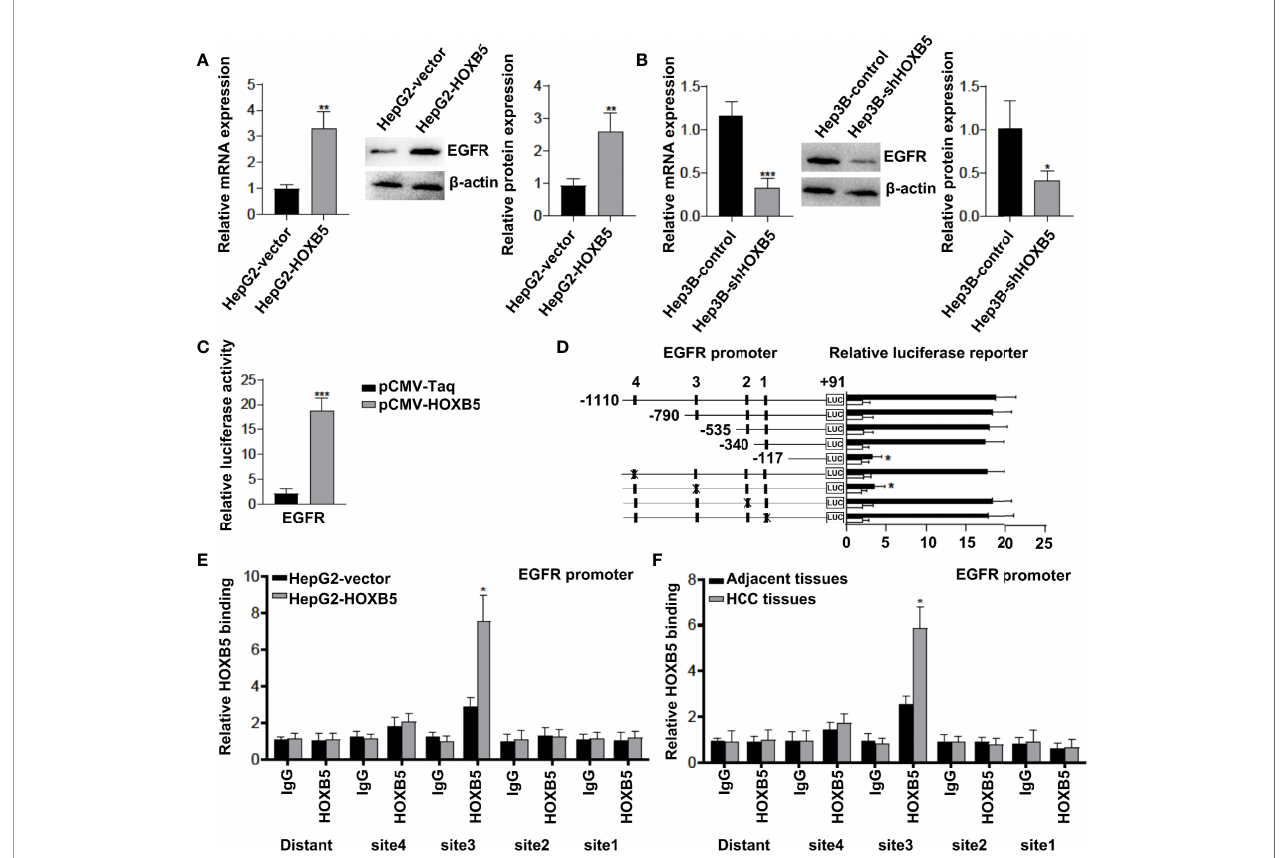
FIGURE 3 | EGFR is a direct transcriptional target of HOXB5. (A, B) Expression of EGFR in HepG2-HOXB5 and Hep3B- sh HOXB5, and their corresponding control cell lines as tested by qRT-PCR and Western blot. Data are mean ± SD. * p < 0.05, ** p < 0.01, *** p < 0.001. (C) The luciferase reporter assay demonstrated that ectopic expression of HOXB5 promoted the luciferase activity of the EGFR promoter. (D) EGFR promoter. Serially truncated and mutated EGFR promoter constructs were co-transfected with pCMV-HOXB5, and relative luciferase activities were determined. (E, F) ChIP assays demonstrated the direct binding of HOXB5 to the EGFR promoter in HepG2-HOXB5 cells and the enriched binding of endogenous HOXB5 to the EGFR promoter in primary HCC